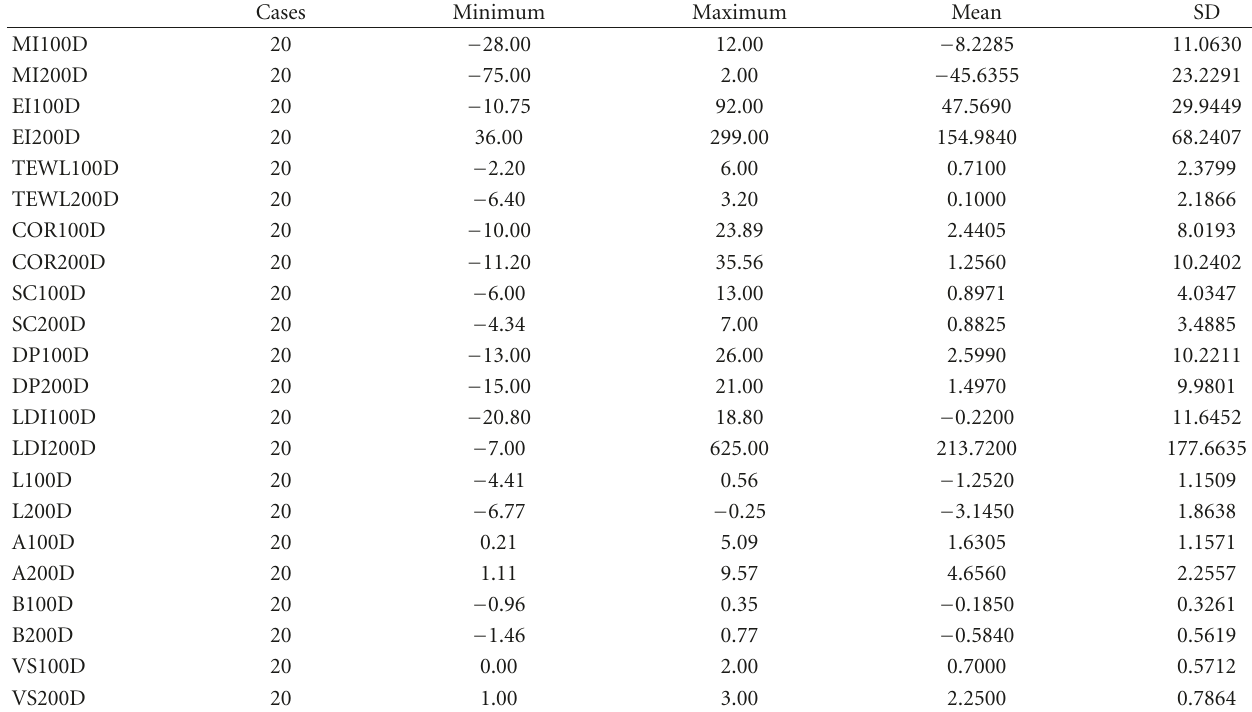
Table 1: The descriptive statistics of mean di ff erences with biomedical techniques. EI, COR, and a ∗ increase with higher UVB irradiation. On the contrary, MI, L ∗ , and b ∗ decrease. Discrepancy: TEWL, COR, SC, DP, LDI.